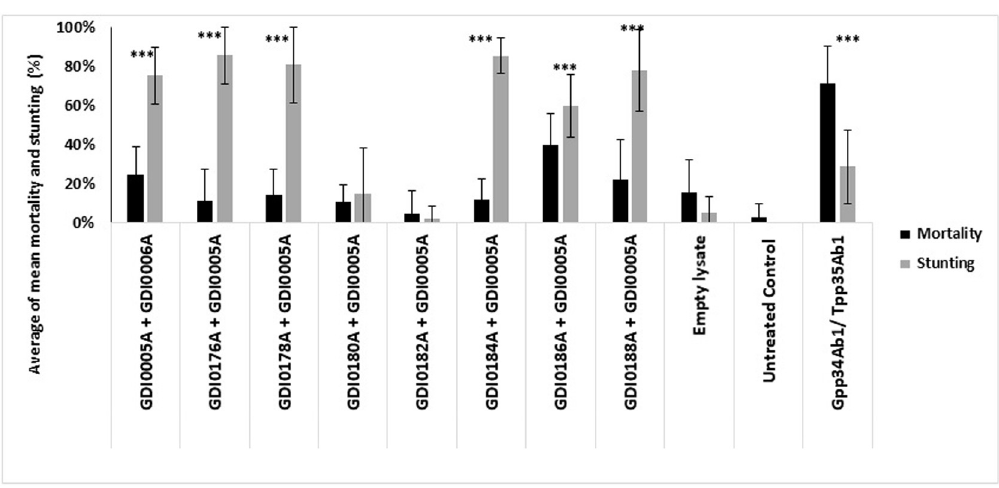
Fig 7. Cross activity between component I (GDI0005A and homologues) and component II (GDI0006A and homologues). Activity was evaluated on neonates of western corn rootworm (WCR) 5 days after treatment and infestation by assessing the percentage of mortality (black boxes) and the percentage of stunting (grey boxes). Each larva was exposed to ~200 μ L of WCR artificial diet overlaid with 20 μ L of bacterial lysate mixtures containing (GDI0005A+GDI0006A) or (GDI0005A combined with GDI0006A homologs). Negative controls were lysates from E . coli bacteria transfected with the empty expression plasmid (empty lysate) and sterilized water (untreated control). The positive control were lysates from bacteria transfected with a plasmid expressing the commercial Gpp34Ab1/Tpp35Ab1 binary proteins. Six 96-well plates each with 8 wells per treatment were used, totaling a sample size of 48 per treatment. A Fisher exact test was used to compare treatment results to the empty lysate at significance levels of P < 0.05 � , < 0.005 �� , < 0.001 ��� . The untreated control was only used to evaluate the quality and reliability of each bioassay. The error bars show the standard error of the mean (SEM).